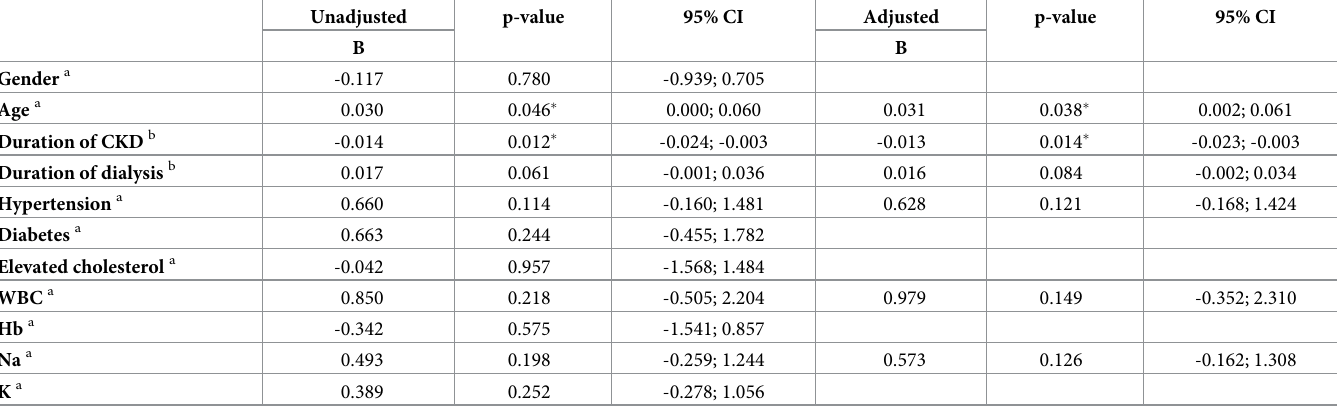
Table 5. Association of chronic kidney disease-associated pruritus with demographics (n = 262).